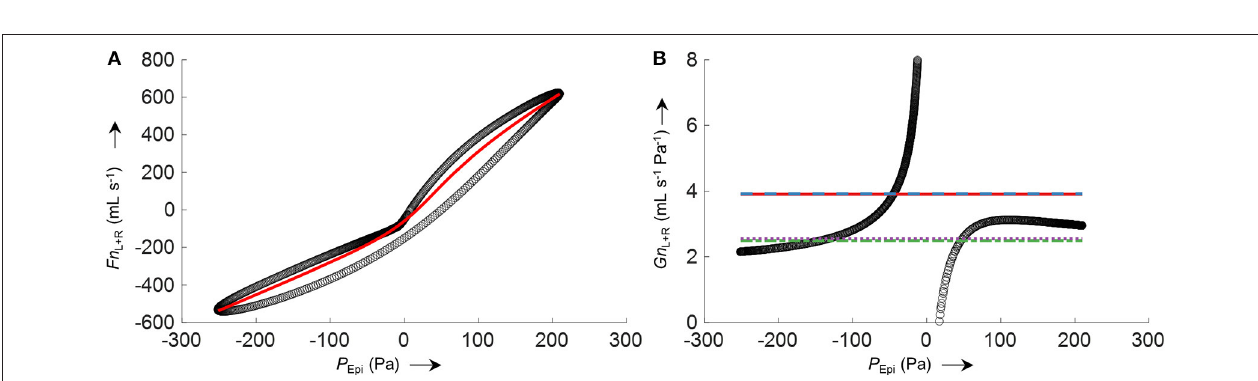
FIGURE 7 | Comparison of derived ( Fn ) and measured airflow ( F PNT ). (A) Identity plot of left and right nasal pressure derived nasal airflow ( Fn L measured by a flow meter ( F PNT ). The dashed gray line indicates identity. (B) Bland-Altman plot; the solid line represents the mean difference (bias), dashed lines represent limits of agreement ( 1.96 SD). Values from 5 analyzed subjects (different colors) were included (563’000 paired measurements). Averaged periods of ± breath with a VT < 200mL or > 800mL (attributed to mouth breathing, mask leaks, or recording/processing errors) were excluded from the comparison.